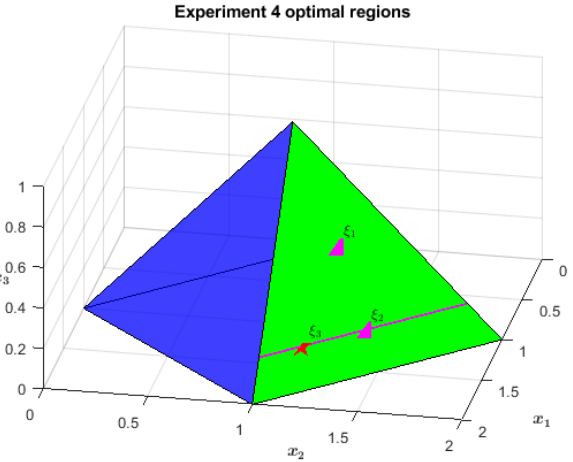
Figure 8. The surface in green is the optimal region of the first objective ( ξ 1 is its midpoint); the segment in magenta is the also optimal region for the second objective ( ξ 2 is its midpoint); ξ 3 is the global